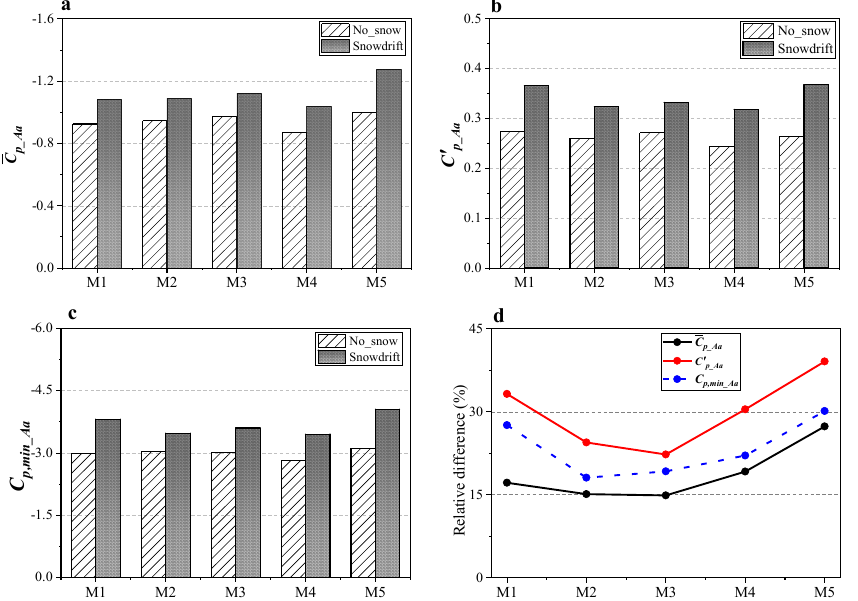
Figure 14. Comparisons of area average values of wind pressure coefficients in the windward region (( a ) 𝐶̅ 𝑝_𝐴𝑎 ; ( b ) 𝐶 𝑝_𝐴𝑎′ ; ( c ) 𝐶 𝑝_𝐴𝑎 ; ( d ) RD value).